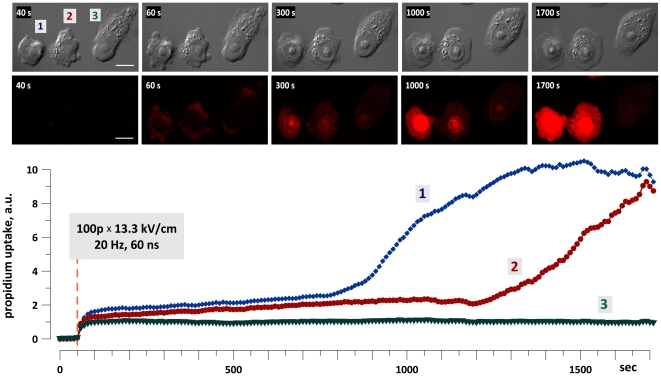
Two distinct modes of propidium uptake in EP-exposed cells.A group of three CHO cells attached to a coverslip was exposed to an EP train at 50 s into the experiment. Exposure parameters are indicated in the figure. Insets show differential-interference contrast and fluorescent images of cells at selected timepoints. Scale bars: 10 µm. The images were taken every 10 s throughout the experiment. The graph shows the time dynamics of Pr uptake by cells 1, 2 and 3. Note the immediate increase in Pr fluorescence in all three cells, caused by electropore opening and transient Pr uptake. Following the transient uptake, the intensity of fluorescence displayed little changes until membrane rupture and massive Pr entry in cells 1 and 2, but not in cell 3.